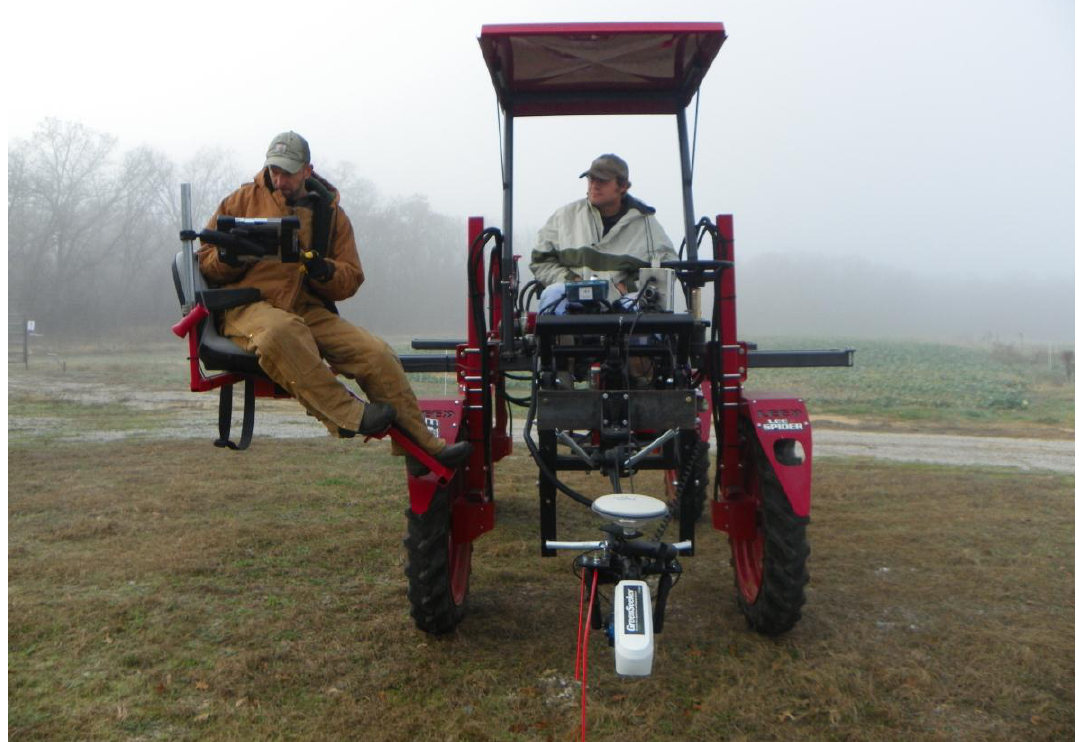
Figure 5. Spyder used for transport of sensors across wheat